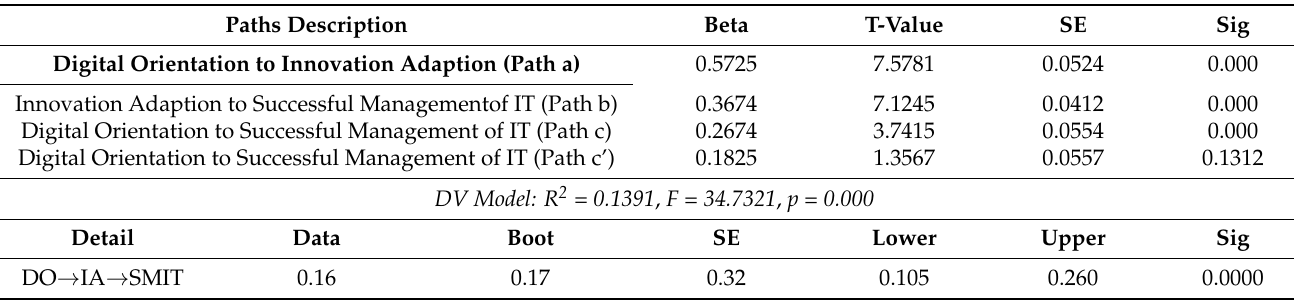
Table 5. (Mediating Effect of Innovation Adaption between Digital Orientation and Successful Management of